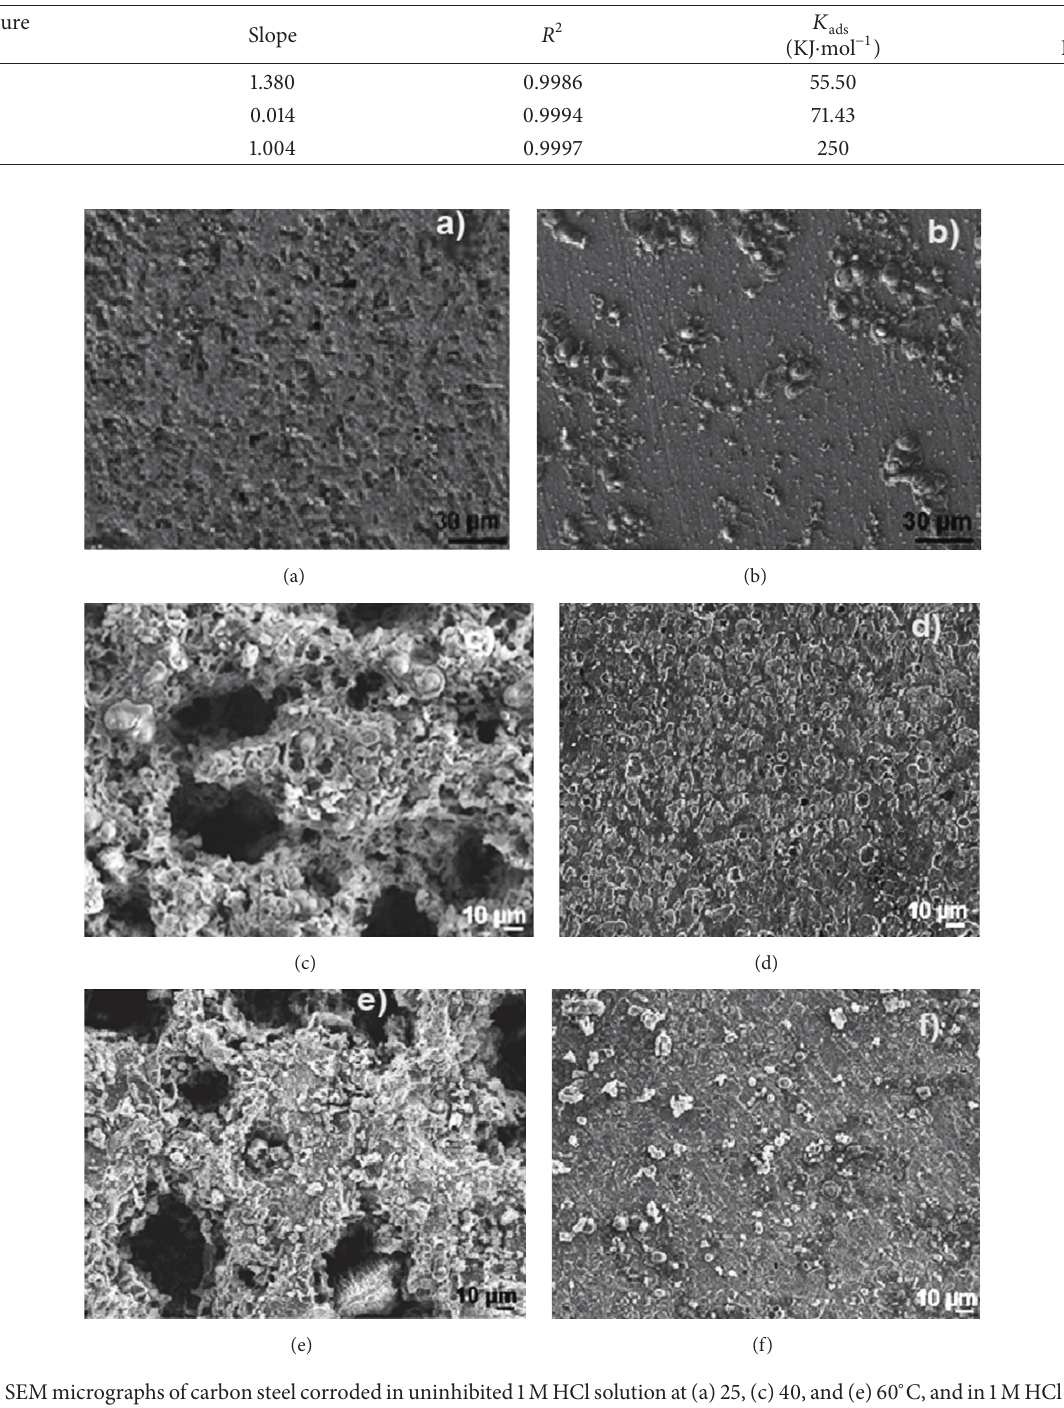
Figure 11: SEM micrographs of carbon steel corroded in uninhibited 1M HCl solution at (a) 25, (c) 40, and (e) 60 ∘ C, and in 1 M HCl solution + 75 ppm of inhibitor at (b) 25, (d) 40, and (f) 60 ∘